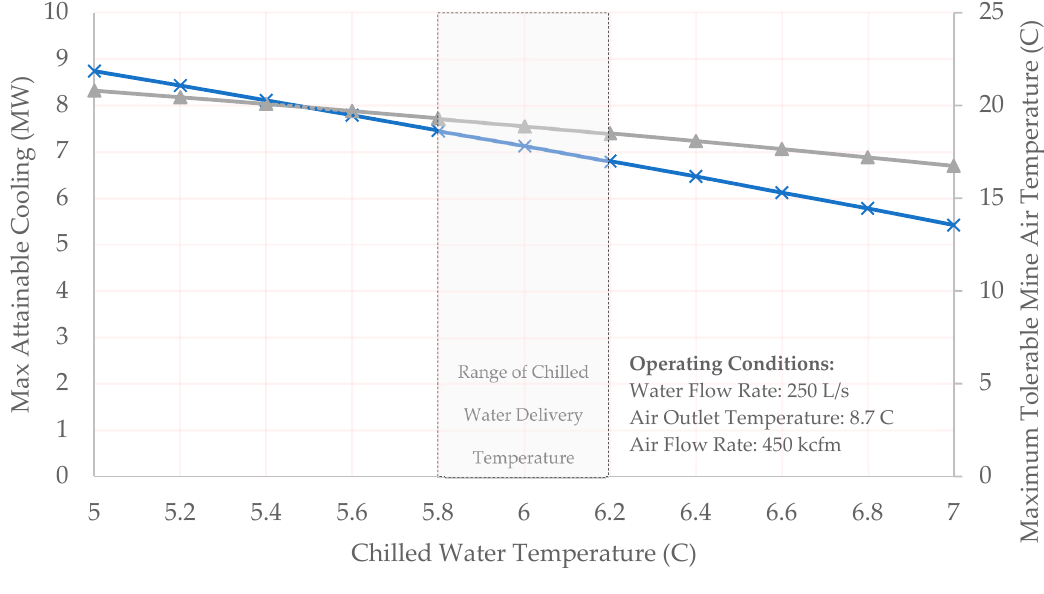
Figure 11. Underground plant design and operating ranges showing maximum attainable cooling power at different surface ambient temperatures.